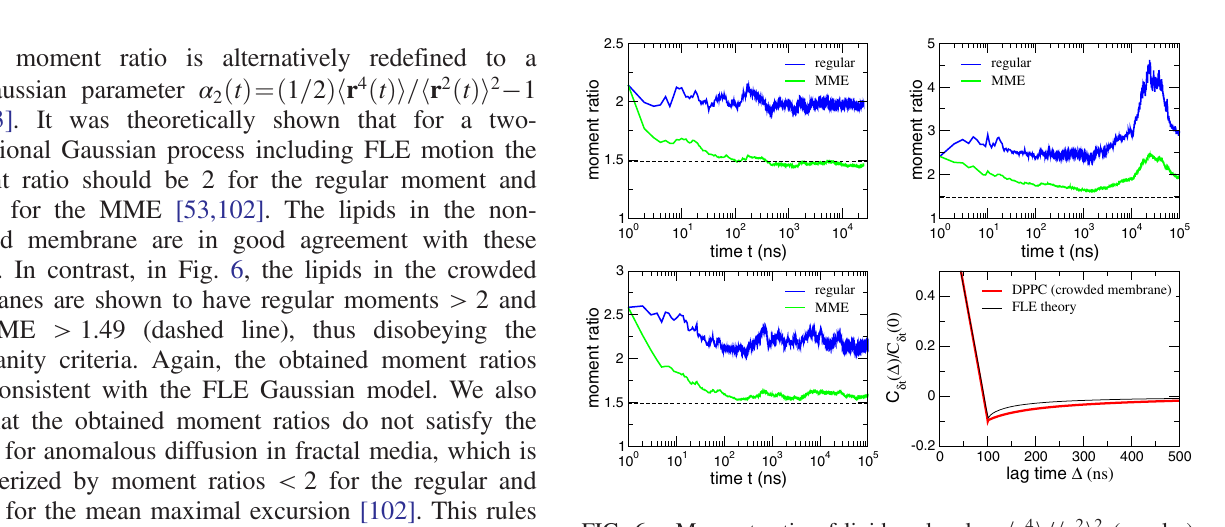
FIG. 5. Cumulative distribution Π ð r 2 ; Δ Þ and propagator P r ð r; Δ Þ for proteins: (top) Protein-poor DPPC, (middle) protein-rich DPPC, and (bottom) protein-rich DLPC membranes. For all panels the color code denotes the results at Δ ¼ 1 ns (red), 10 ns (green), 100 ns (blue), 1000 ns (brown), and 5000 ns (magenta). As in Fig. 4, the dashed and solid lines in log P r ð r; Δ Þ represent the fit curve using the Gaussian and the non-Gaussian propagators, respectively. The annotated δ values are the estimated non-Gaussian exponents δ from fitting.